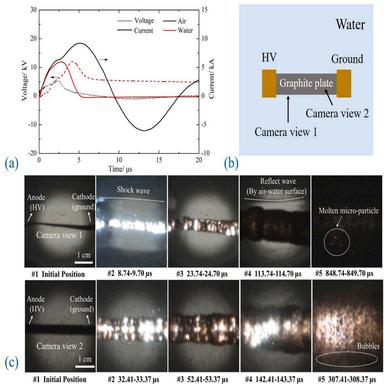
Waveforms for the circuit current and voltage of the graphite plate explosion in air and water (a), schematic of camera shooting directions (b), and the discharge shadow images (c).